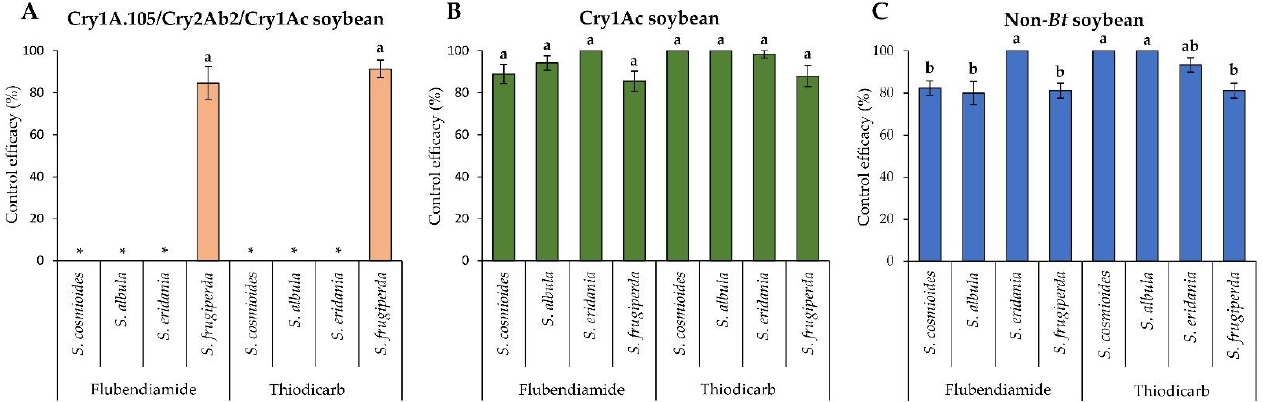
Figure 1. Control efficacy of flubendiamide and thiodicarb against Spodoptera species larvae that developed to L3 stage on Bt and non- Bt soybean. Bars (±SE) with the same letter are not significantly different as determinded by the LSMEANS statement using Tukey – Kramer test at p > 0.05. * Not estimated due to limited number of larvae that developed until L3 stage.